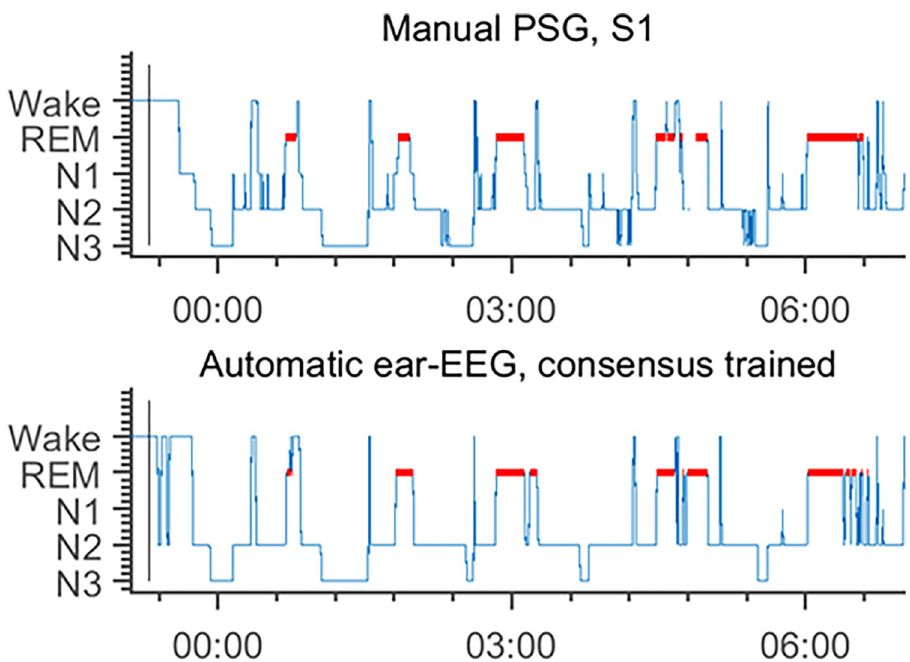
Fig 2. An example of two hypnograms based on two different ways to do sleep scoring. Top panel: Gold standard PSG based on six channel EEG, two channel EMG and two channels EOG. Bottom panel: Automatic ear-EEG based on 12 ear-EEG electrodes placed 6 in each ear. 30-sec epochs were considered from light out until last wake up followed by unmounting the devices. In this case, lights were out at 22:13. The Cohens Kappa value for this set of scorings is κ = 0.78. This indicates a substantial agreement and is generally acceptable. When looking more carefully the automatic ear-EEG-based scoring seems to miss a few of the nightly awakenings.